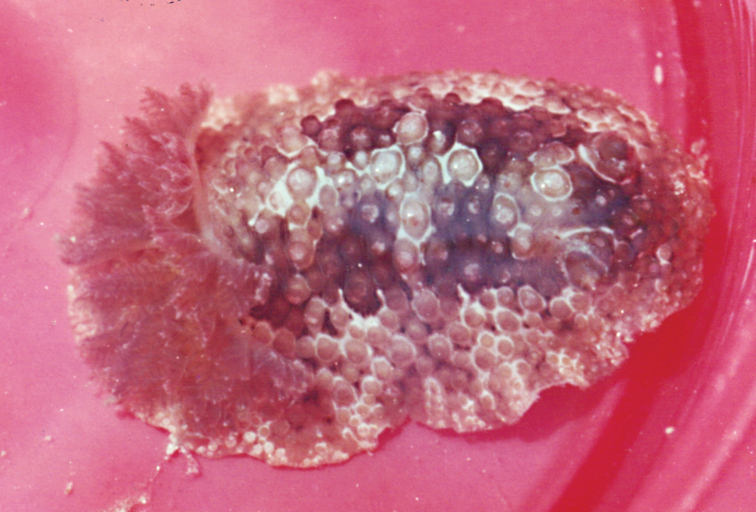
Carminodoris grandiflora, 30 mm pres., Zanzibar, photo: MD Richmond.